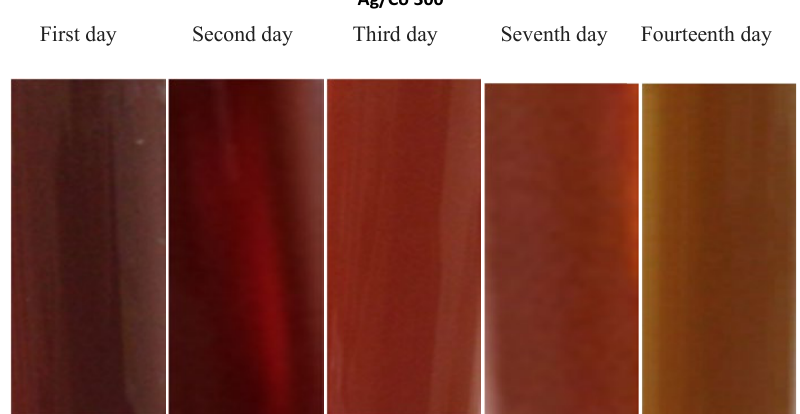
Fig. 5: Silver-cobalt nanoparticles produced from silver nanoparticles at intervals of 300 seconds on the first, second, third, seventh, and fourteenth days (respectively, from left to right)